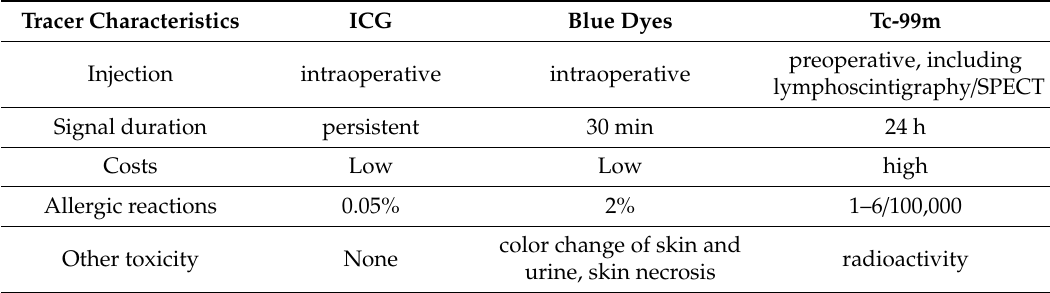
Table 2. Characteristics of tracers for sentinel mapping in endometrial cancer